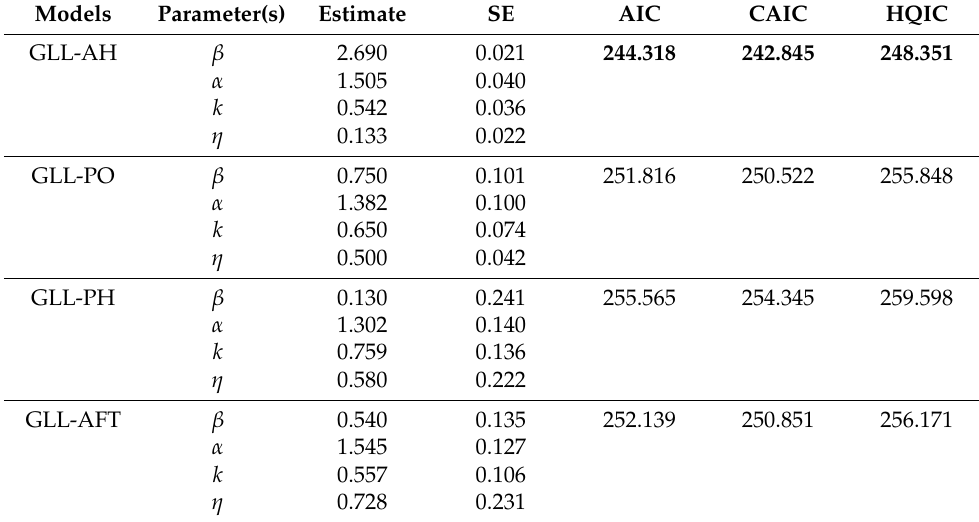
Table 2. Results from the fitted proposed fully parametric AH regression model and other survival regression models with the GLL baseline distribution to gastric cancer